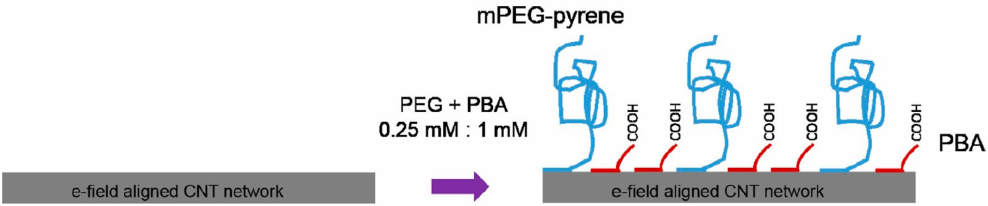
Figure 9. Surface modification of the CNT network surface with mixed-SAMs constituting of PBA and mPEG-pyrene [107]. Reprinted from Sensors and Actuators B: Chemical, 255, Filipiak et al., Highly Sensitive, Selective and Label-Free Protein Detection in Physiological Solutions Using Carbon Nanotube Transistors with Nanobody Receptors, 1507–1516, Copyright 2018, with permission from